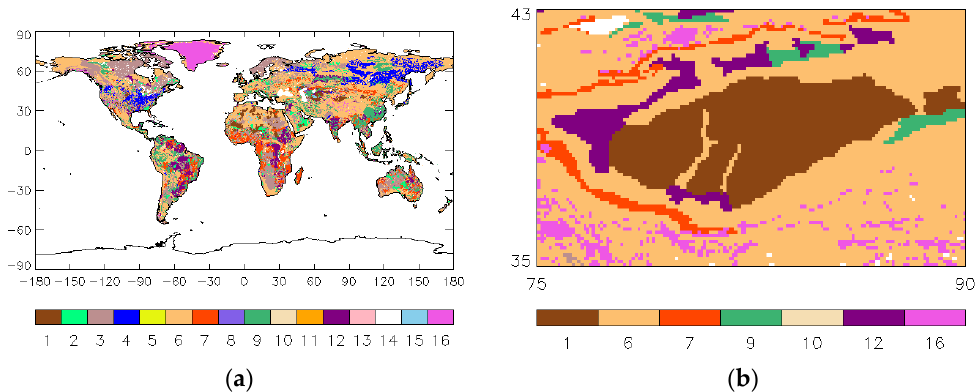
Figure 1. Soil texture ( a ) globally and ( b ) in the Taklimakan Desert study area (see Table 2 for the soil texture codes).